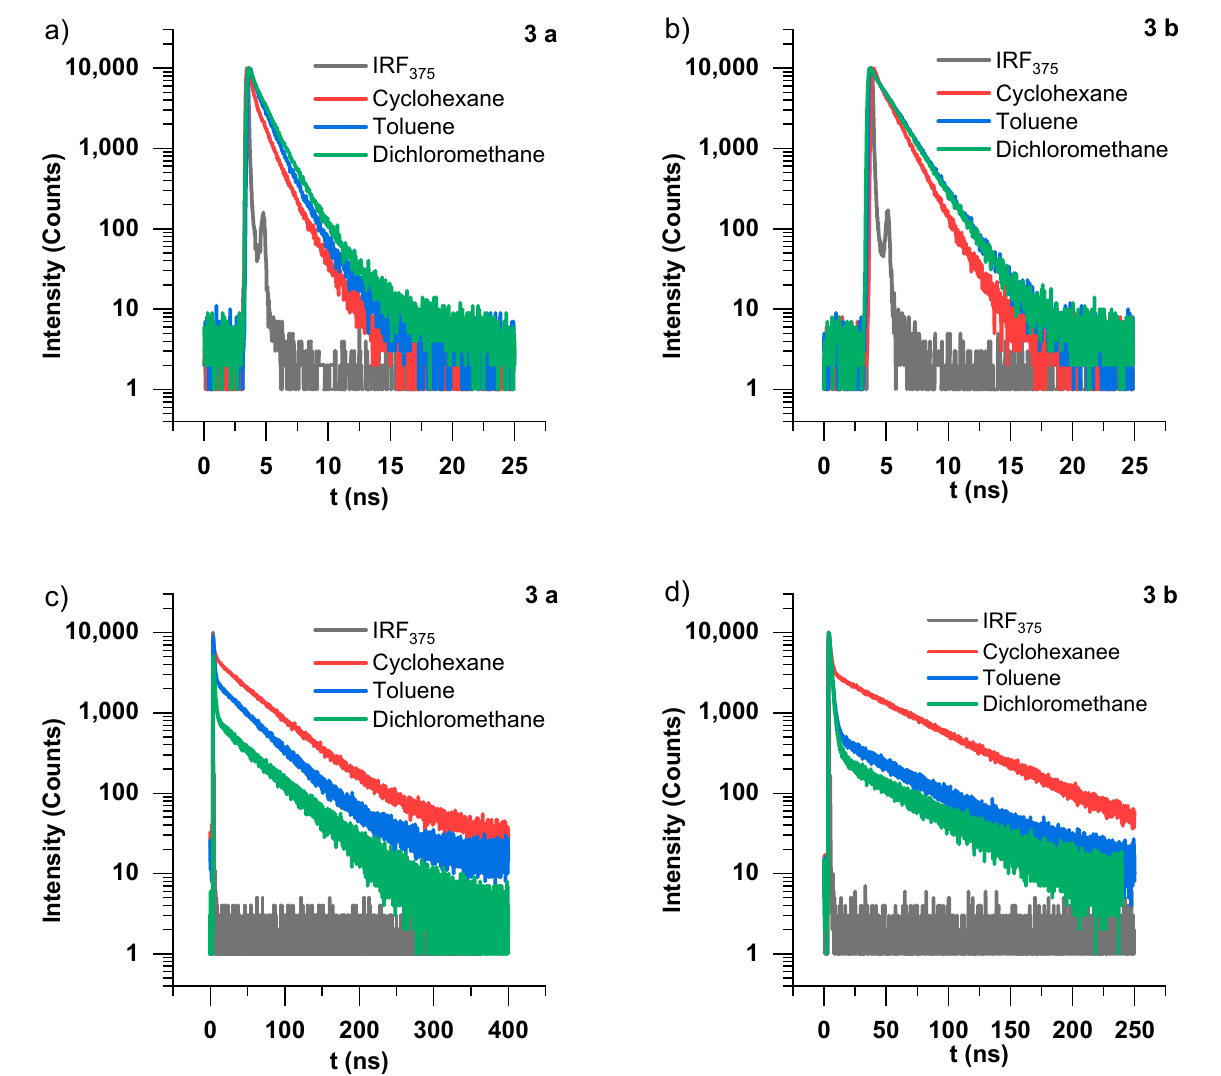
Figure 30. Fluorescence decay curves for polymers 3 a ( a ) and 3 b ( b ) at 436 nm and 3 a ( c ) and 3 b ( d ) at 540 nm in cyclohexane, toluene and dichloromethane compared with instrument response function (IRF) ( λ ex = 375